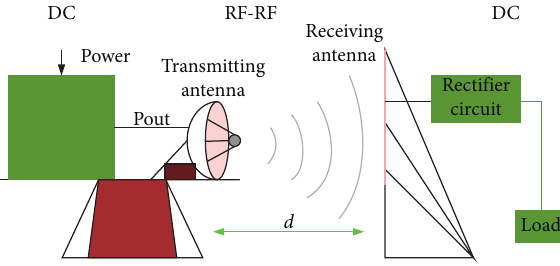
2: Typical strained Ge semiconductor on Si substrate semiconductor (Si and Ge have different thermal expansion co- efficients, and 0.2% tensile strain is introduced into the Ge epitaxial layer during annealing, resulting in band structure change and mobility